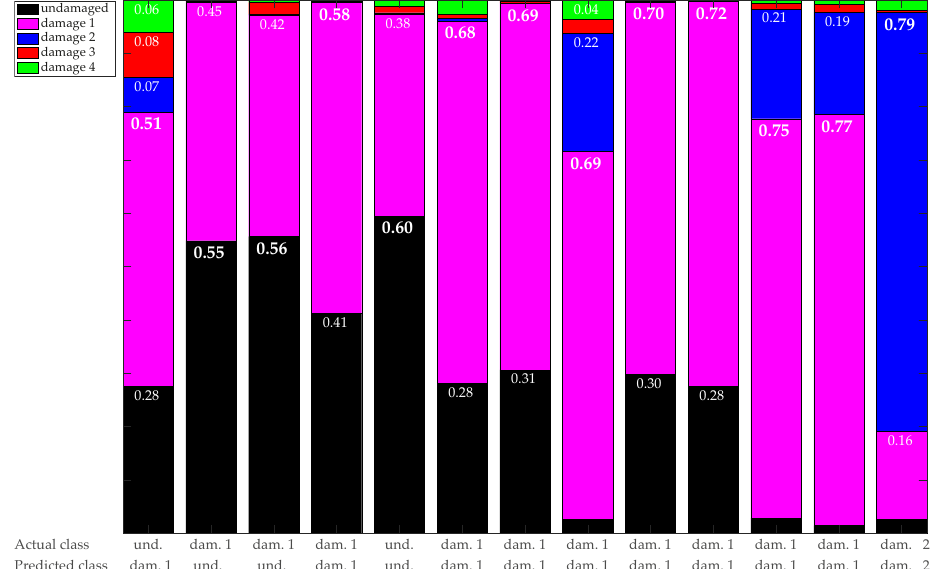
Figure 16. Probability distribution { p i } i = 1,...,5 for samples with p max < 0.8 in the case d = 21 (in the increasing order of p max ). The first three columns are associated with the three samples that are incorrectly